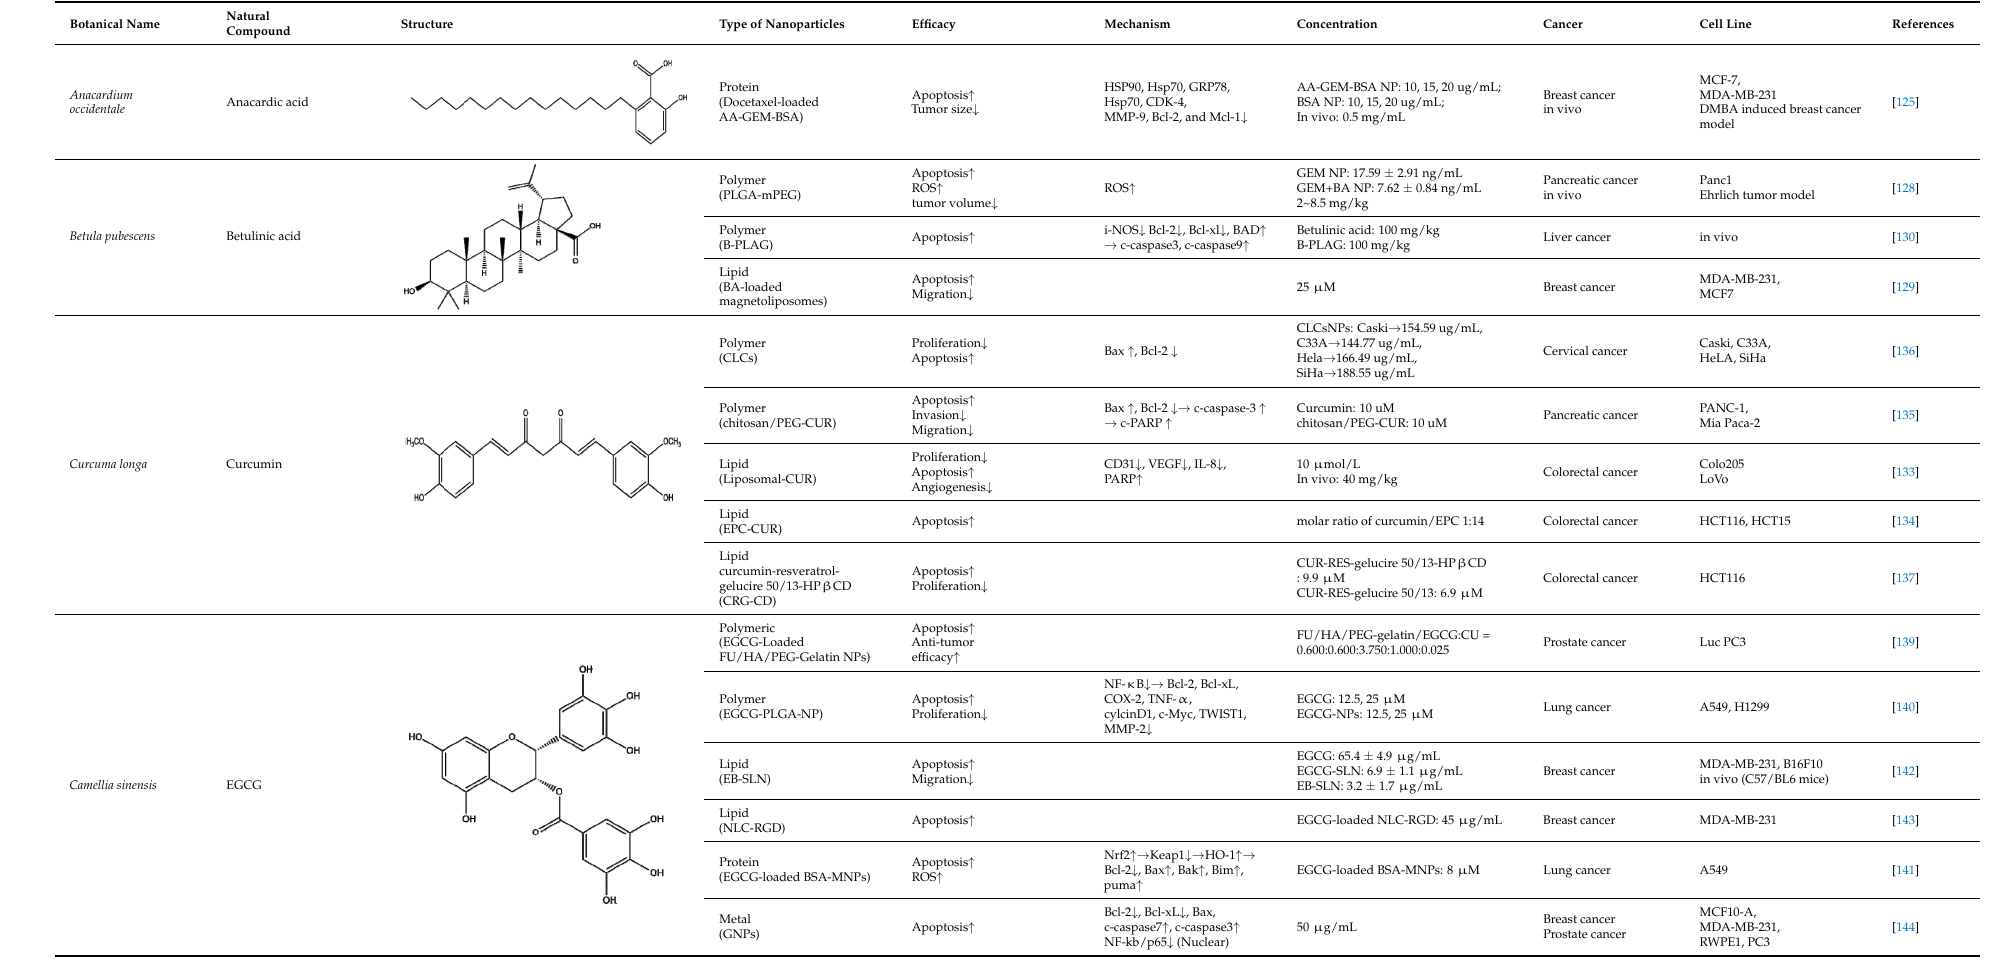
Table 1. Efficacy and molecular mechanism of nano-phytochemicals in several cancers.